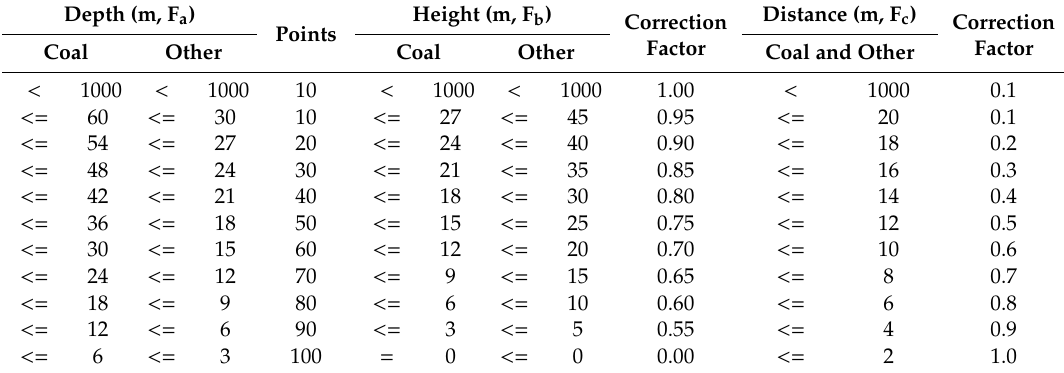
Table 3. Points for direct influence factors with their ranges.